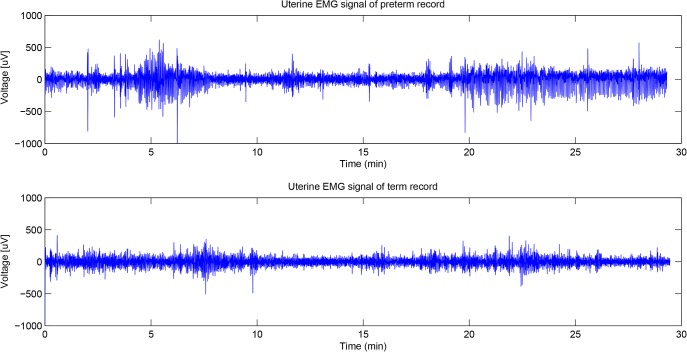
Examples of raw uterine EMG signal records.Data were recorded in the 31th week of gestation. The upper and the lower traces are the examples of preterm delivery (in the 35th week of gestation) and term delivery (in the 40th week of gestation) records respectively.